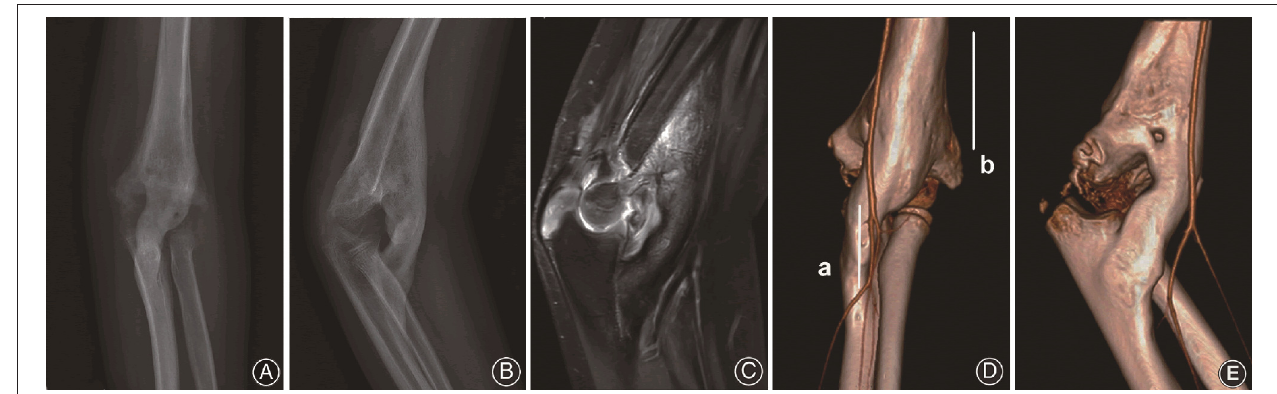
FIGURE 2 | (A,B) Radiograph of the left elbow depicts the bridging myositis over the elbow 9 months after the primary injury. (C) MRI presents the bony myositis between distal humerus and proximal ulna with a smooth elbow joint. (D,E) CTA show brachial artery and the medial artery passing around the bony bridge. Line a and b represent longitudinal incisions along the lateral distal humerus and the medial proximal ulna respectively.